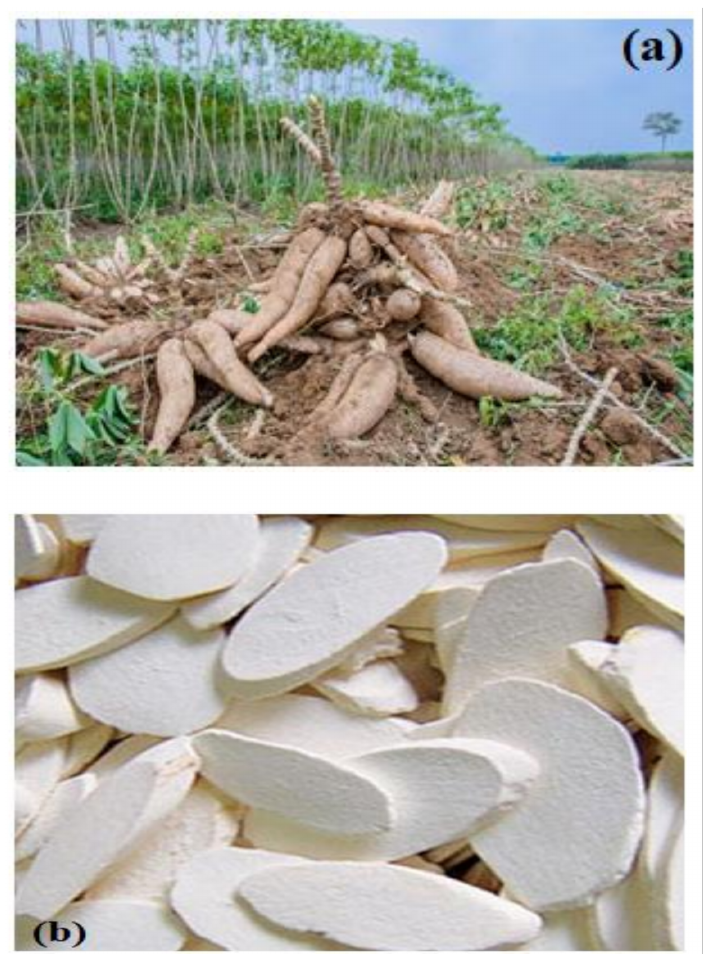
Figure 1. Some pictures of cassava roots. ( a ) Cassava roots with bark from plantations [16], ( b ) cassava roots chips without bark ready to be dried